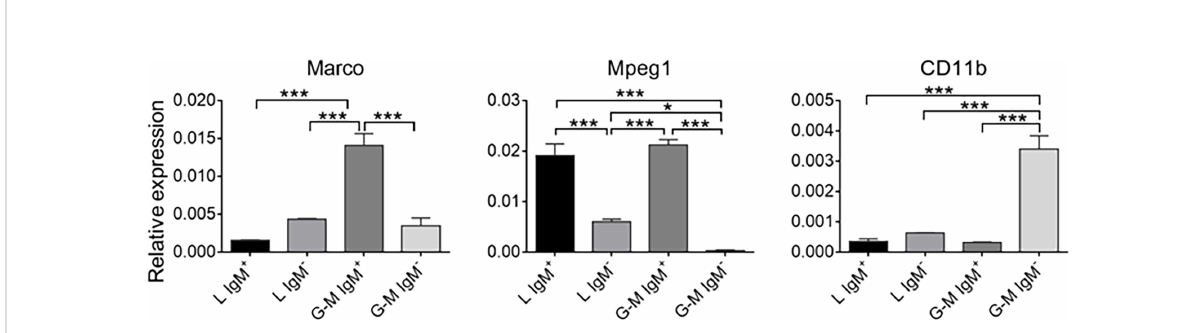
FIGURE 5 Expression patterns of granulocyte- and macrophage-related genes — MARCO , MPEG1 , and CD11b — in tilapia L-gate IgM + , L-gate IgM - , G-M gate IgM + , and G-M gate IgM – cells ( n = 6 fi sh). Asterisks indicate signi fi cant differences (* p ≤ 0.05 and *** p ≤ 0.001).